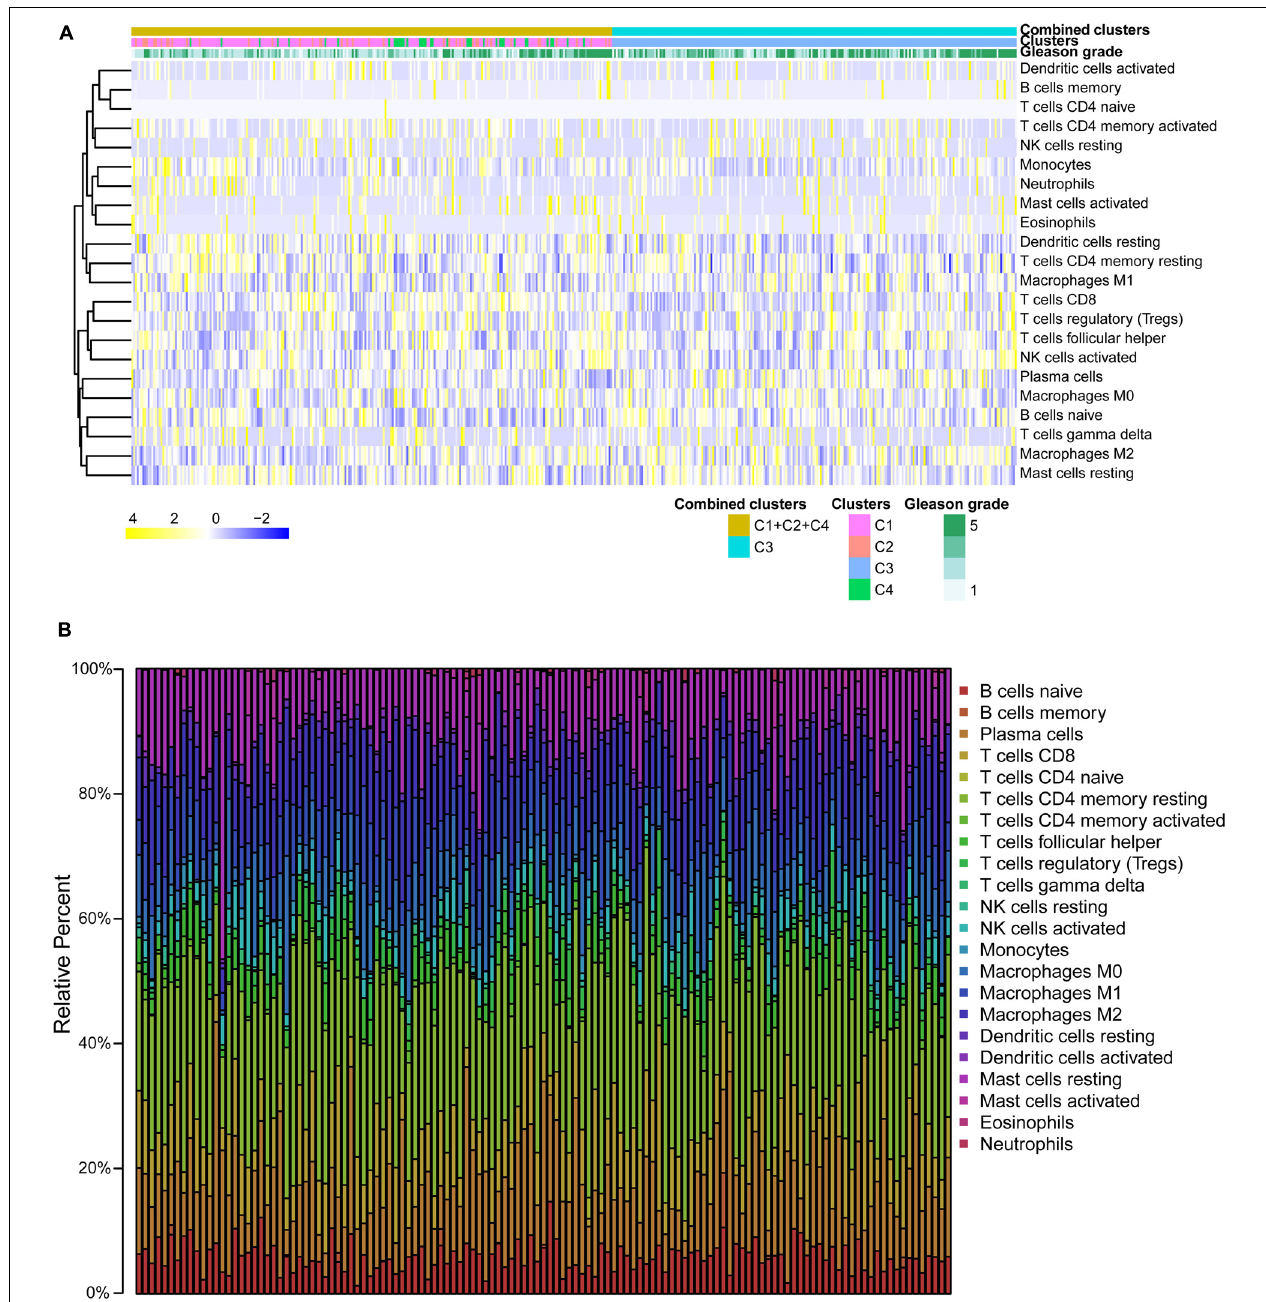
FIGURE 5 | Immune infiltration in each subtype. (A) The heatmap about immune infiltration degree of the 487 patients. (B) Barplot about immune infiltration of patients.